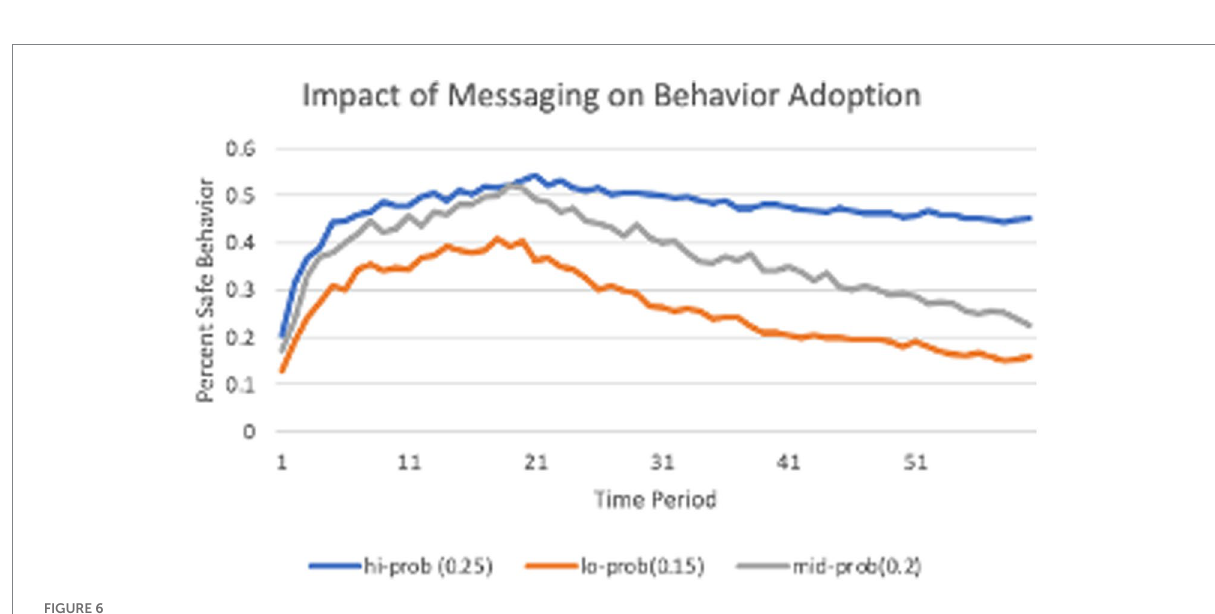
FIGURE 6 The evolving polarization of behavior adoption in response to